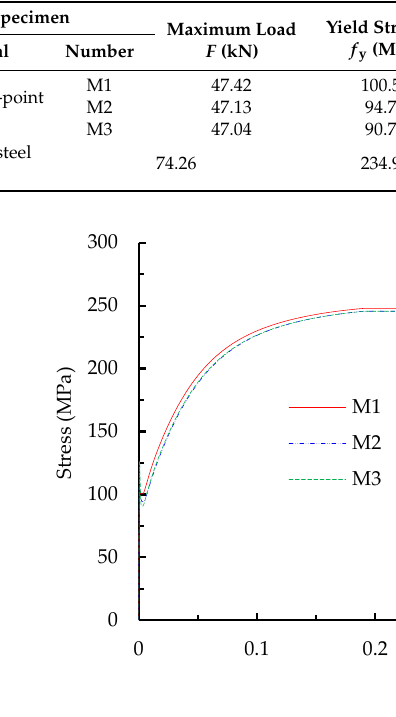
Figure 8. Stress – strain curves of the LYP steel. Figure 8. Stress–strain curves of the LYP